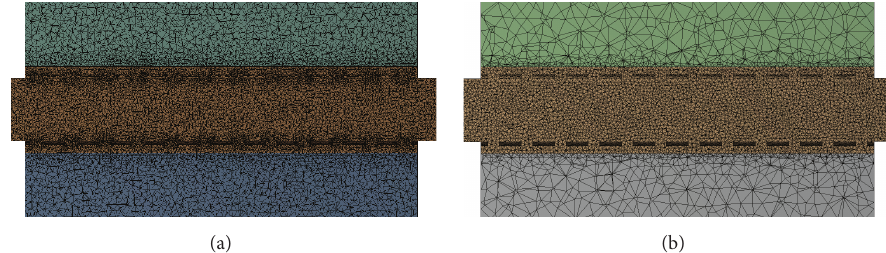
Figure 3: Geometry of meshes for the straight-through perforated pipe silencer: (a) CFD mesh and (b) acoustic